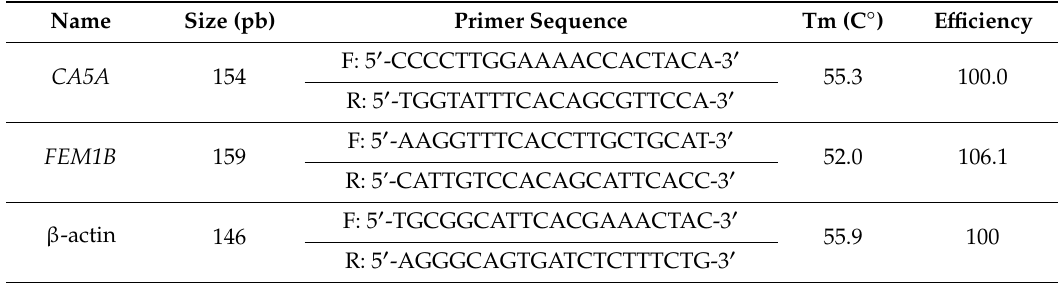
Table 1. Primer sequences used to amplify target genes using by quantitative real-time polymerase chain reaction (RT-qPCR). β -actin for the housekeeping as an internal